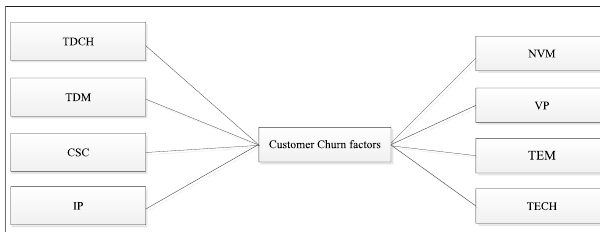
FIGURE 1 | Customer churn